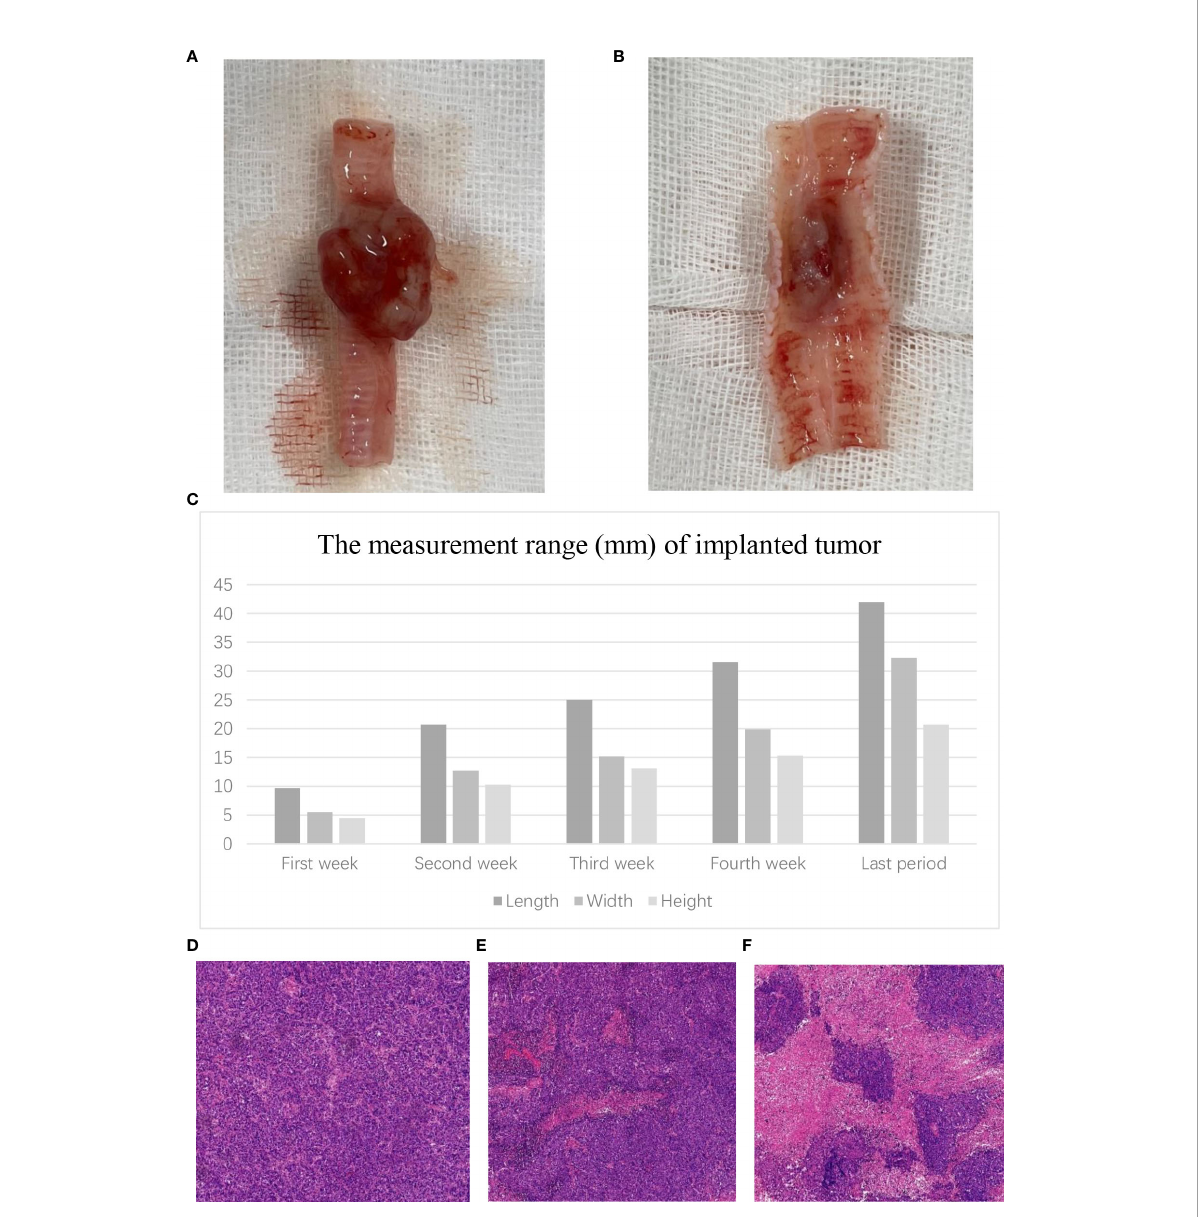
FIGURE 2 Tumor growth in the airway. (A) Macroscopic external view of the tracheal tumor. (B) Macroscopic internal view of the tracheal tumor. (C) The measurement range of the VX2 tumor in different periods. Microscopic view of the tracheal tumor. (D) Tumor cells grew vigorously. (E) Tumor showed slightly necrotic portions. (F) Tumor showed obviously necrotic